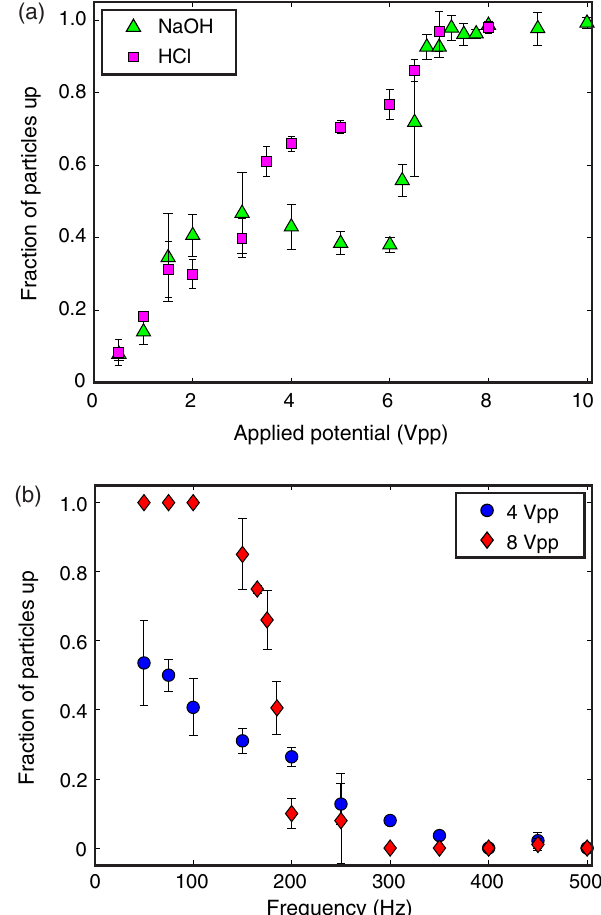
FIG. 4. Electric field dependence of the particle height bifur- cation. (a) Fraction of particles that move up as a function of applied potential for 2 μ m sulfated PS in 1 mM NaOH (green triangles) and 2 μ m aliphatic amine PS in 1 mM HCl (magenta squares). The frequency is held constant at 100 Hz. (b) Fraction of 2 μ m sulfated PS particles that move up in 1 mM NaOH as a function of frequency for two applied potentials indicated in the figure. Each data point is the mean of at least three trials, error bars are 2 standard deviations of the